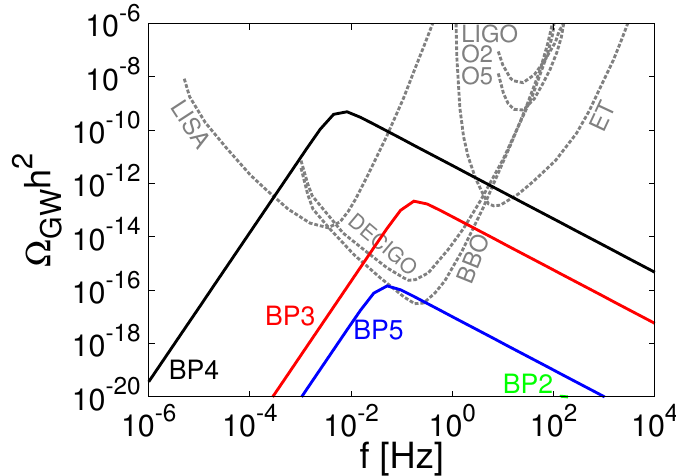
Figure 6 . The GW power spectra for benchmark points of the SU(2) X Model in table 2 and figure 5. The signals of BP1 and BP6 are too small to